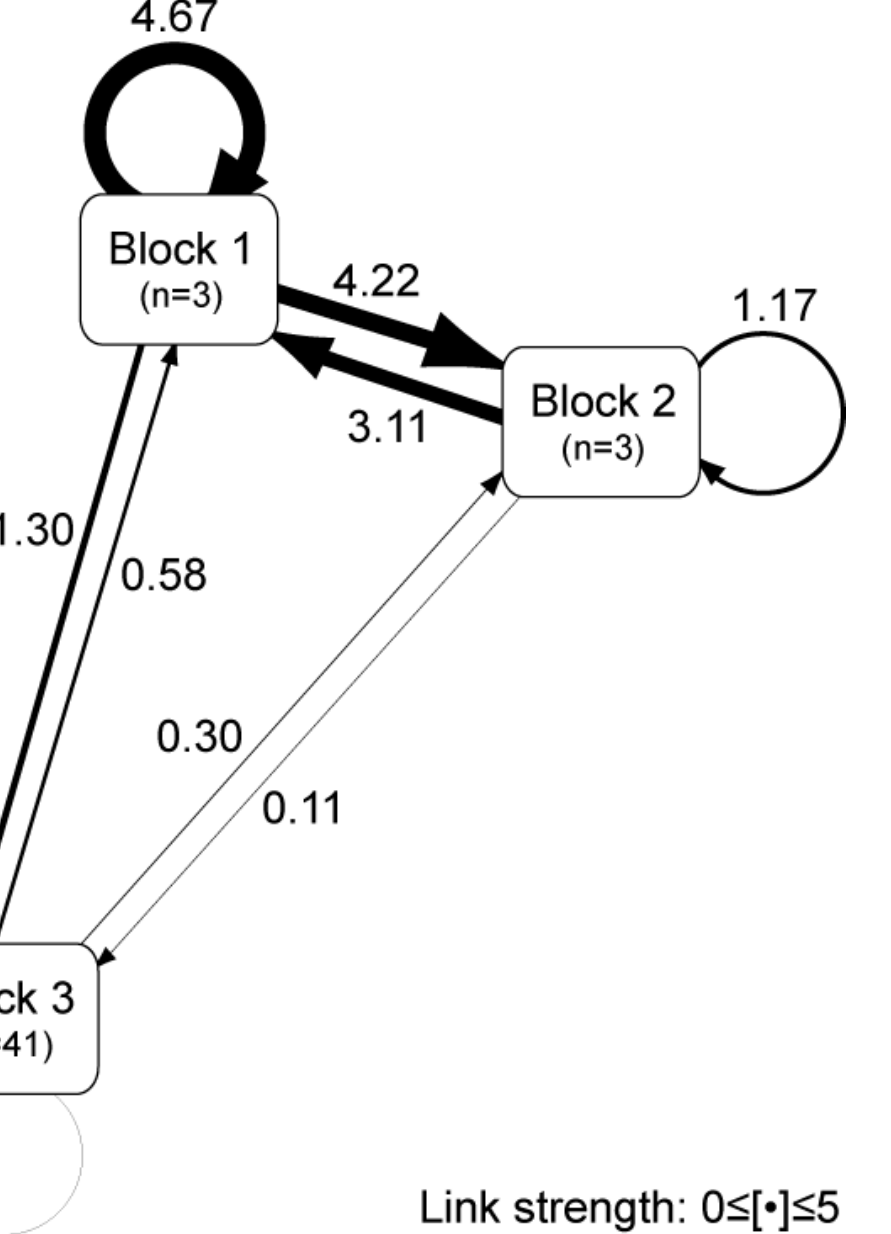
Fig. 4. The figure shows the simplified movement network reached through a block model of the Main Component with three structurally equivalent positions (Blocks 1–3). The blocks were dubbed core, semi-core, and periphery position, respectively, and contained the following SMOs: Block 1 = [N16, N37, N60]; Block 2 = [N9, N25, N31]. Block 3 contained all 41 other